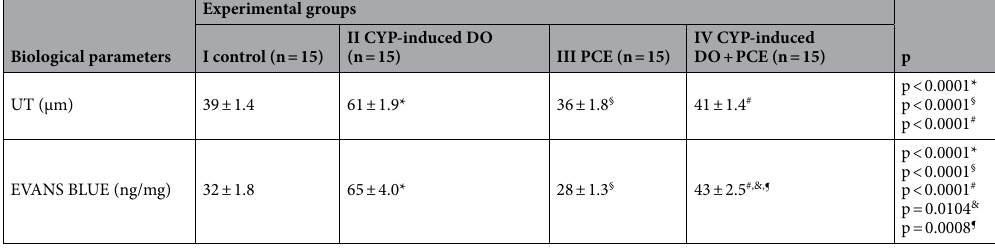
Table 1. Biological parameters of experimental groups. *Statistically significant differences between group I and group II (p ≤ 0.05), § Statistically significant differences between group II and group III (p ≤ 0.05), # Statistically significant differences between group II and group IV (p ≤ 0.05), & Statistically significant differences between group I and group IV (p ≤ 0.05), ¶ Statistically significant differences between group III and group IV (p ≤ 0.05).